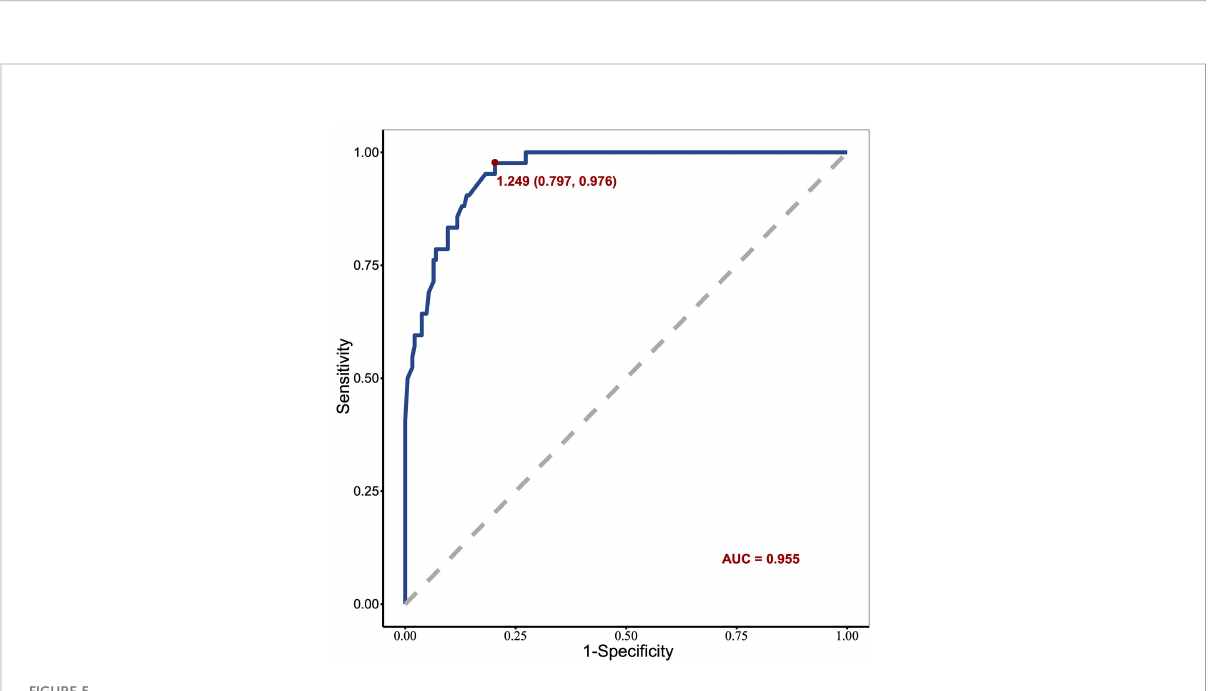
FIGURE 5 Receiver operating characteristic curve of the nomogram in the study